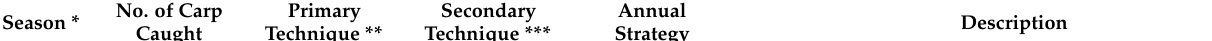
Table 1. Summary of techniques and strategies used to eradicate carp from Lake Crescent (1995–2010).